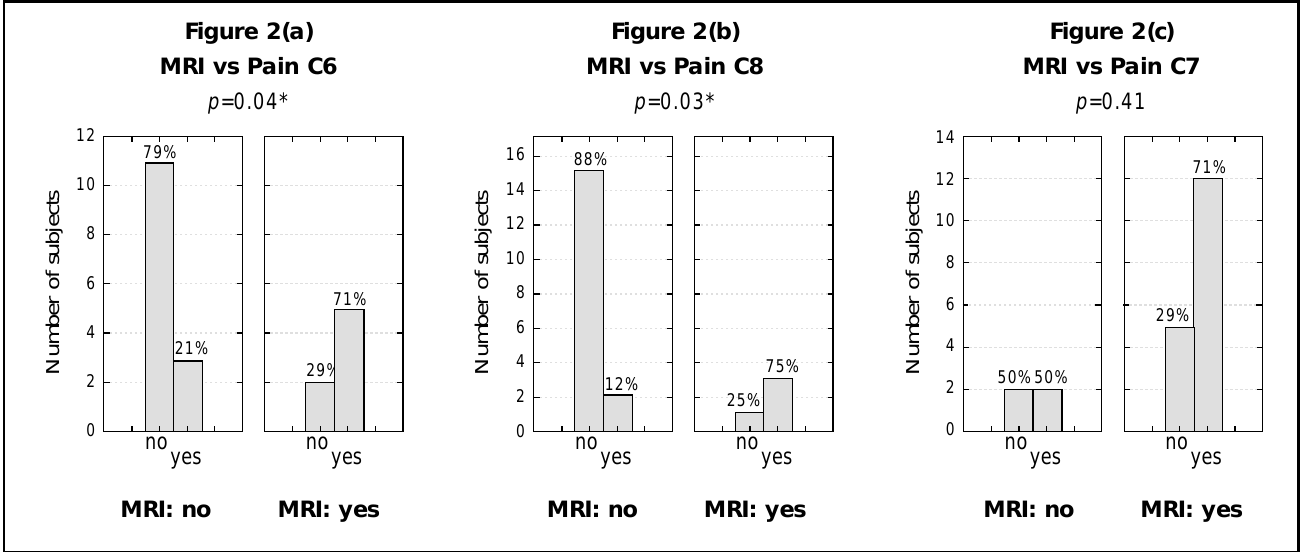
2: Comparison between MRI findings and dermatomal area(s) of radicular pain as determined during the interview for (a) C6, (b) C8 and (c) C7 NR involvement (Fisher exact, one-tailed test and